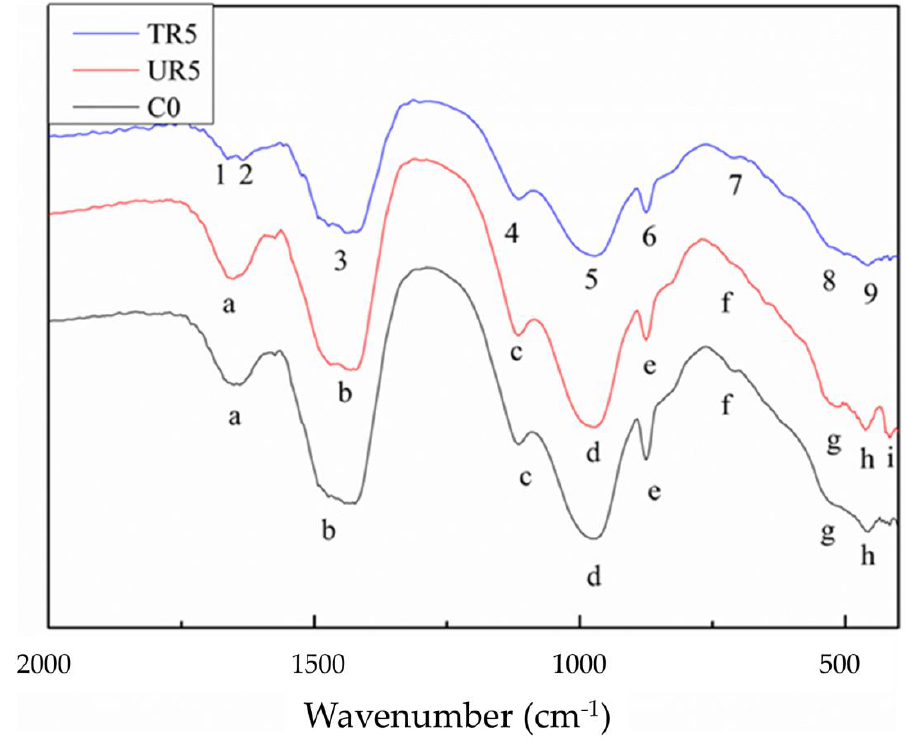
Figure 8. Intermolecular interaction forces between the C-S-H probe and the as-received rubber (UR) or the treated rubber (TR).